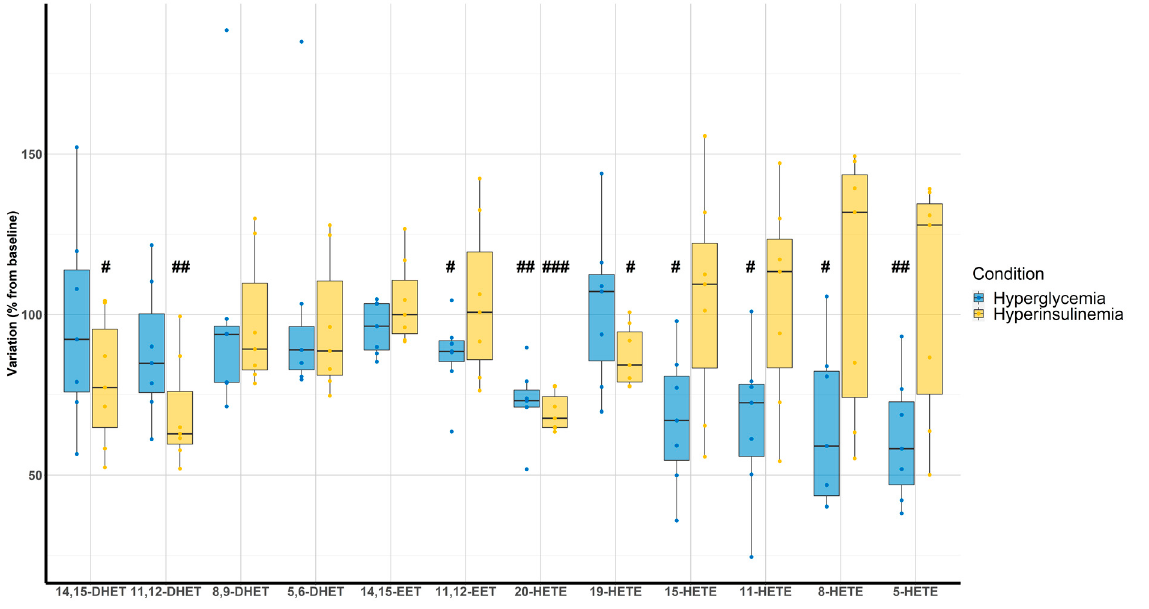
Figure 4. Evaluation of DHETs, EETs, and HETEs variation according to hyperglycemic (blue) and hyperinsulinemic euglycemic (yellow) clamps compared with baseline (n = 7). # p < 0.05, ## p < 0.01, ### p < 0.001.